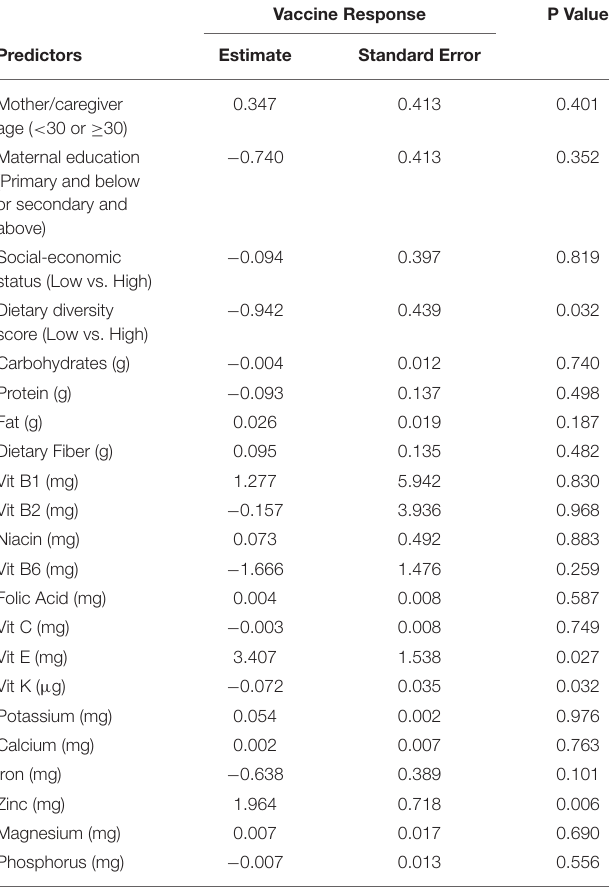
TABLE 6 | Multivariate analysis (logistic regression) between vaccine response and dietary intake. Vaccine